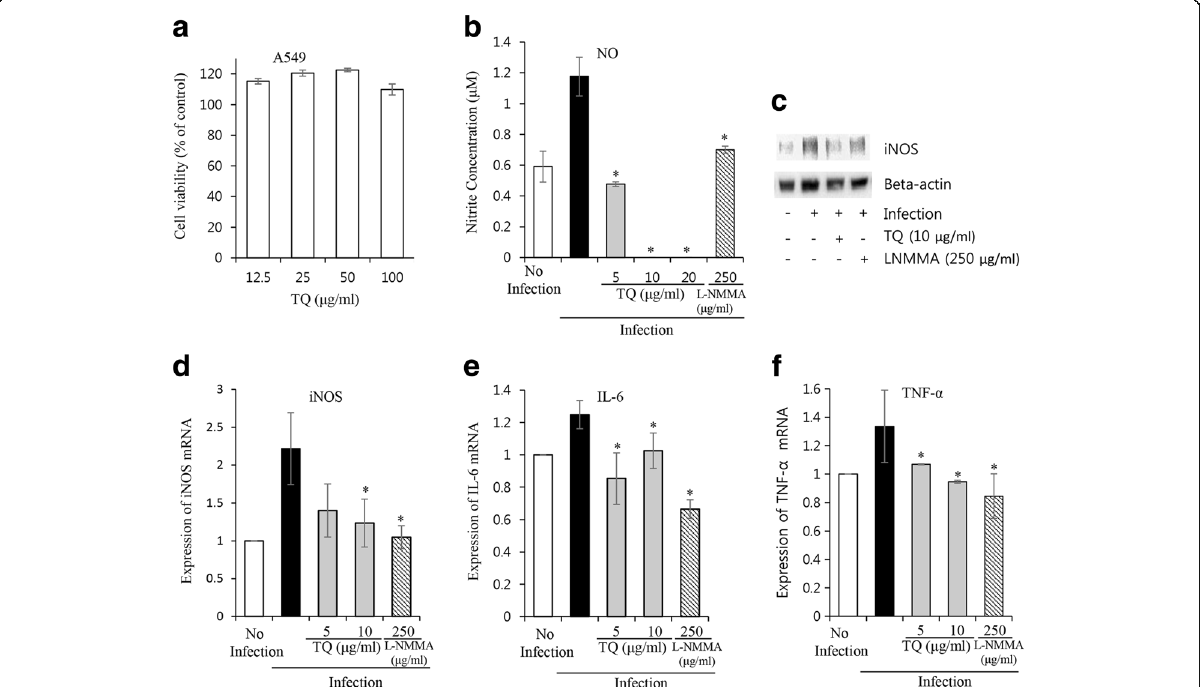
Fig. 3 The effect of TQ on MTB-induced NO expression in Type II human alveolar A549 cells. A549 cells were infected with H37Rv for 3 h at an MOI of 1:10 at 37 °C with 5% CO 2 , followed by drug treatment for 24 h. a Cytotoxicity of TQ on A549 cells. b Effect of TQ on nitric oxide production in H37Rv- infected A549 cells. Data represent the mean ± SD of 3 independent experiments done in triplicate. * P < 0.05 by Student ’ s t-test. c Western blot result showing the changes in iNOS protein expression upon TQ treatment; representative result from a triplicate experiment. d qRT-PCR result showing the changes in iNOS mRNA expression. e Changes in IL-6 mRNA expression. f Changes in TNF- α mRNA expression due to TQ treatment. Data represent the mean ± SD of triplicates of an individual experiment and are representative of 3 independent experiments. * P < 0.05 by a two-tailed Student ’ s